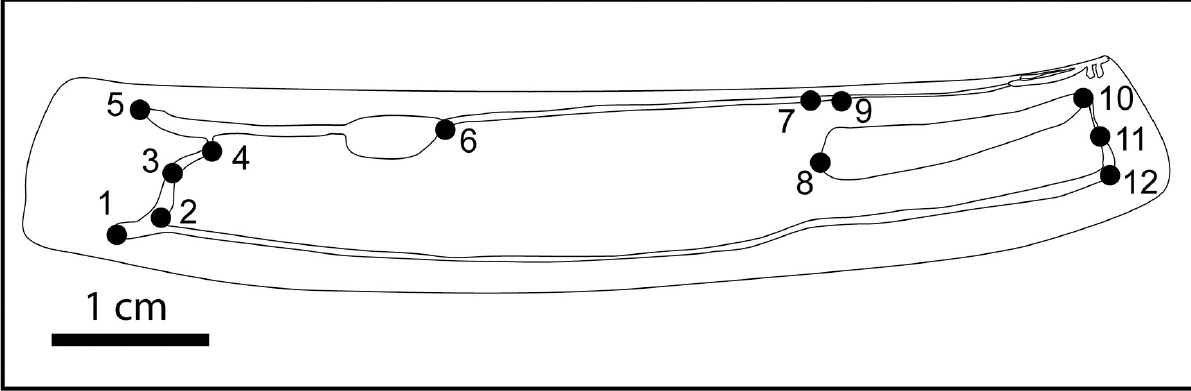
Fig. 2. – Position of the 12 landmarks on the inner surface of the left valve used to test the shape variation in Ensis loboi n. sp. and E. macha . The landmarks are postero-dorsal mantle projection (1), dorsal limit of pallial sinus (2), middle limit of pallial sinus (3), ventral limit of pallial sinus (4), postero-ventral mantle projection (5), posterior adductor muscle scar (6), horizontally oriented cardinal teeth (7, 9), internal end of anterior adductor muscle (8), antero-ventral mantle projection (10); middle point of anterior pallial line (11) and antero-dorsal mantle projection